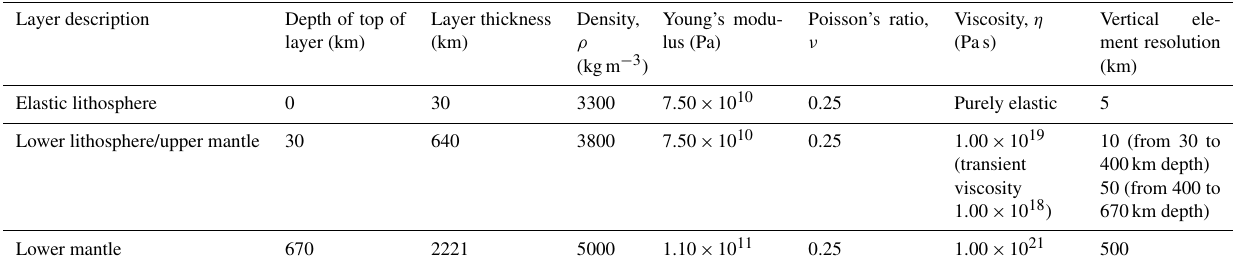
Table 2. Earth model used in the Abaqus model for the benchmarking exercises with a Maxwell rheology and a Burgers rheology (transient viscosity given in brackets). The Maxwell viscosity profile is also used in conjunction with the PREM elastic structure for test case 3. Layer